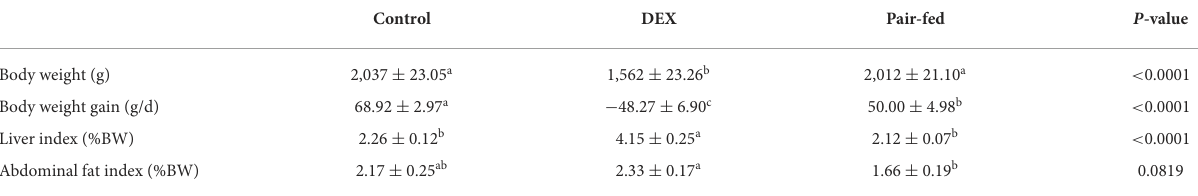
TABLE 3 Effects of dexamethasone on broiler performance.